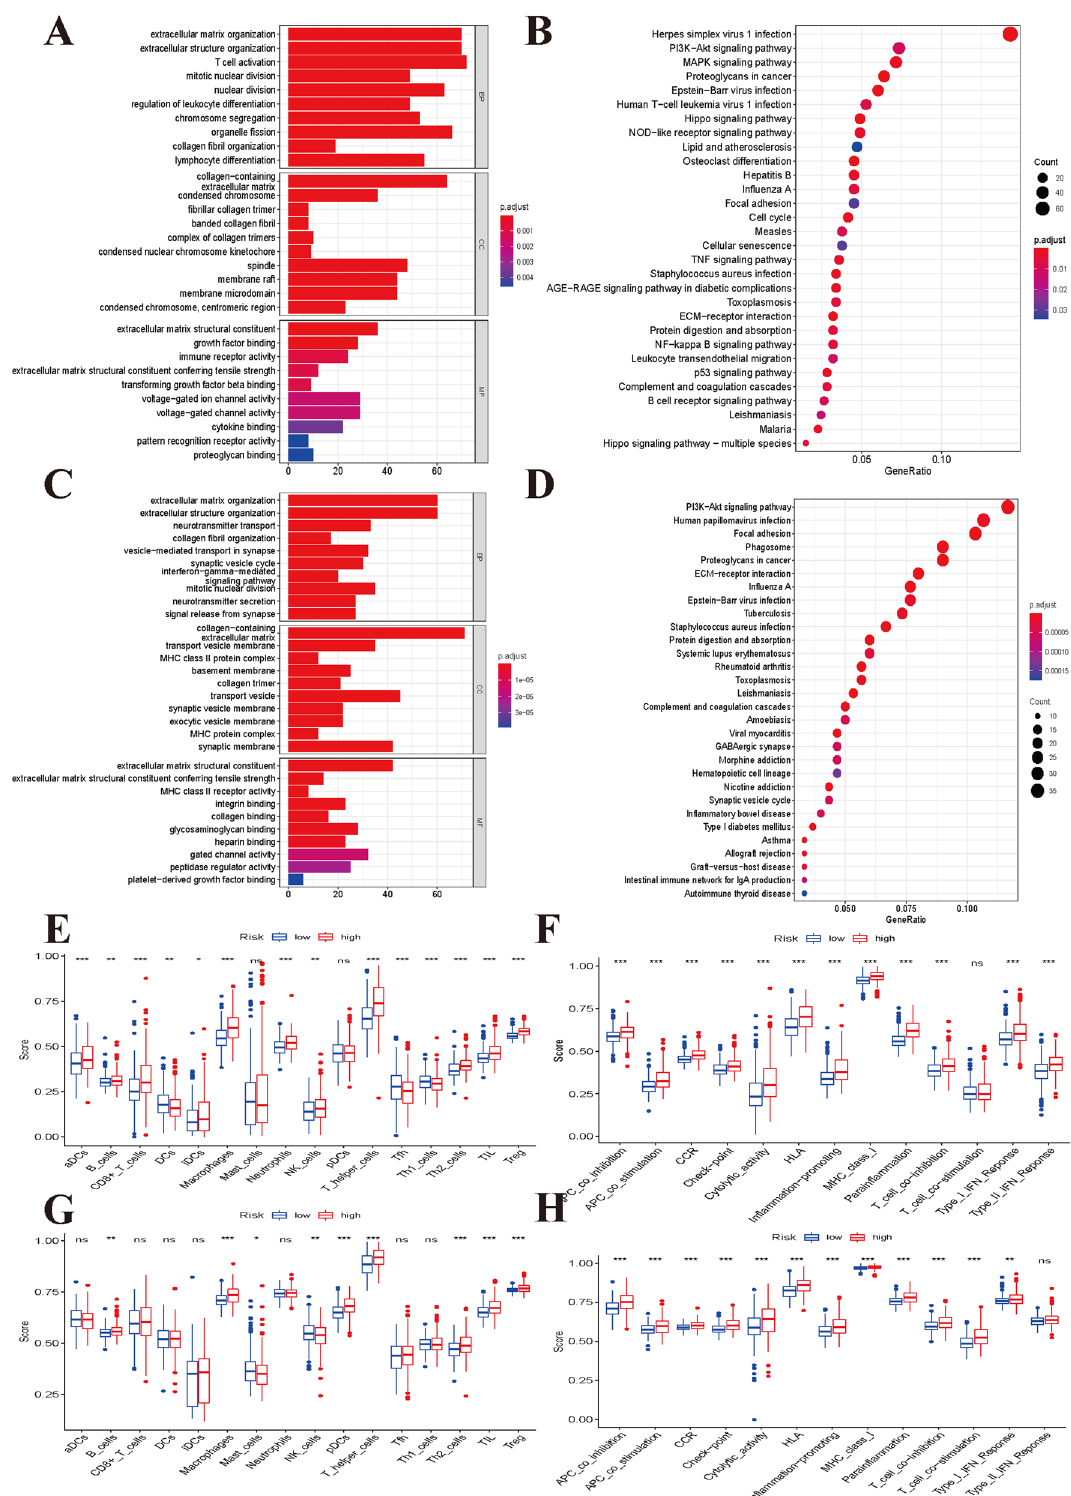
Figure 6. Function enrichment and immune status analyses between high- and low-risk groups (Permission for KEGG has been obtained from Kanehisa laboratories). ( A ) GO enrichment and ( B ) KEGG pathway analyses based on differentially expressed genes between high- and low- risk groups in CGGA cohort. ( C ) GO enrichment and ( D ) KEGG pathway analyses based on differentially expressed genes between high- and low- risk groups in TCGA cohort. (E) Comparisons of immune cells and (F) immune-related pathways between high- and low-risk groups in CGGA cohort. (G) Comparisons of immune cells and (H) immune-related pathways between high- and low-risk groups in TCGA